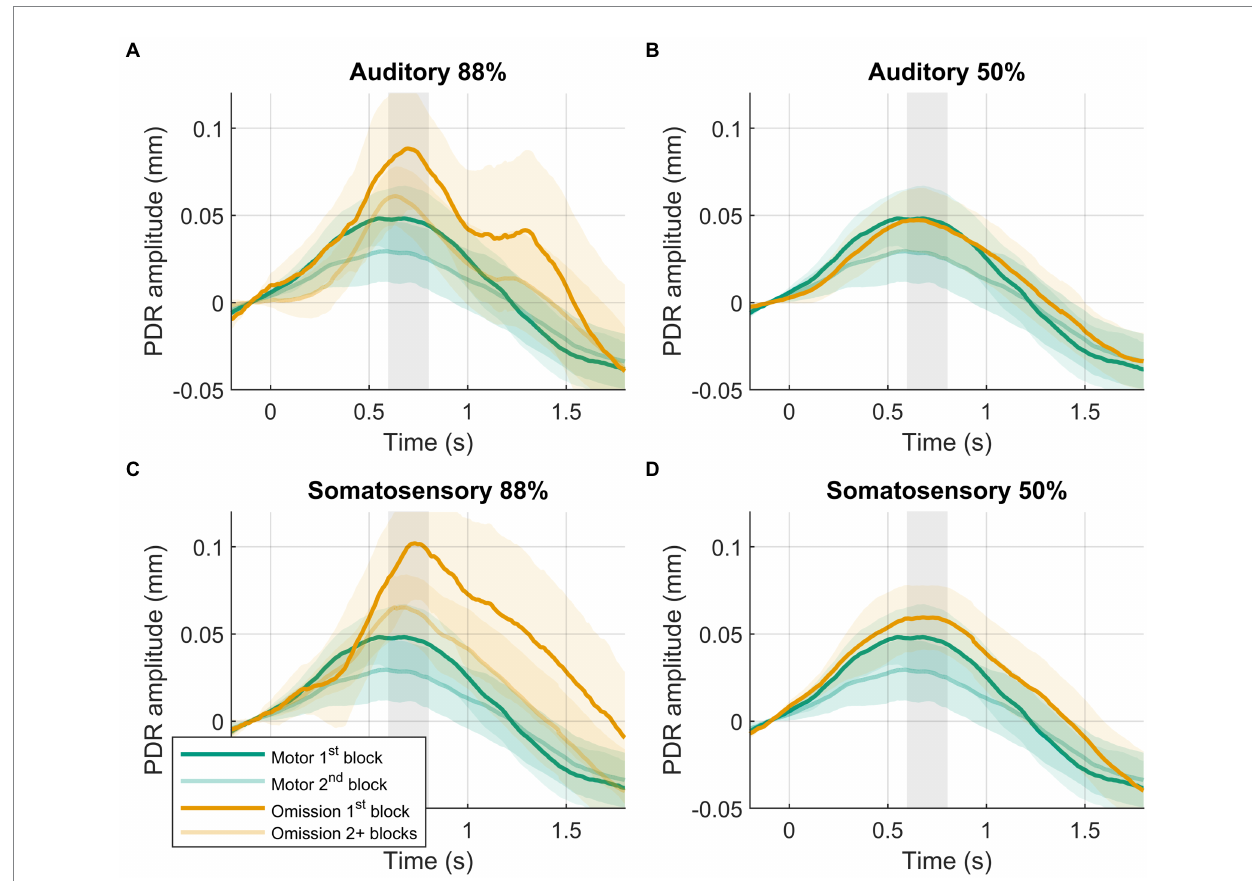
FIGURE 3 Results of post-hoc analysis. PDRs +95% confidence intervals of motor-control (green) and omission (orange) trials. (A) Auditory 88%-condition. (B) auditory 50%-condition. (C) Somatosensory 88%-condition. (D) Somatosensory 50%-condition. PDRs of first block are shown in opaque to show results of interest, following blocks are transparent. Time-window for statistical analysis shown in